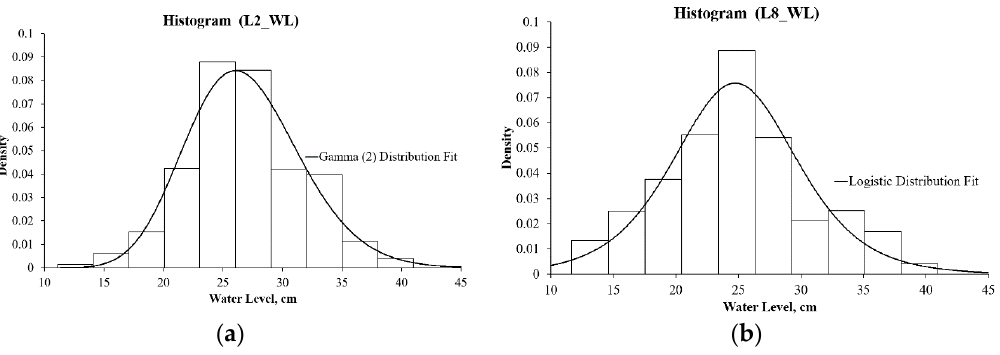
Figure 9. ( a ) L2_WL data distribution fitting; ( b ) L8_WL data distribution fitting.